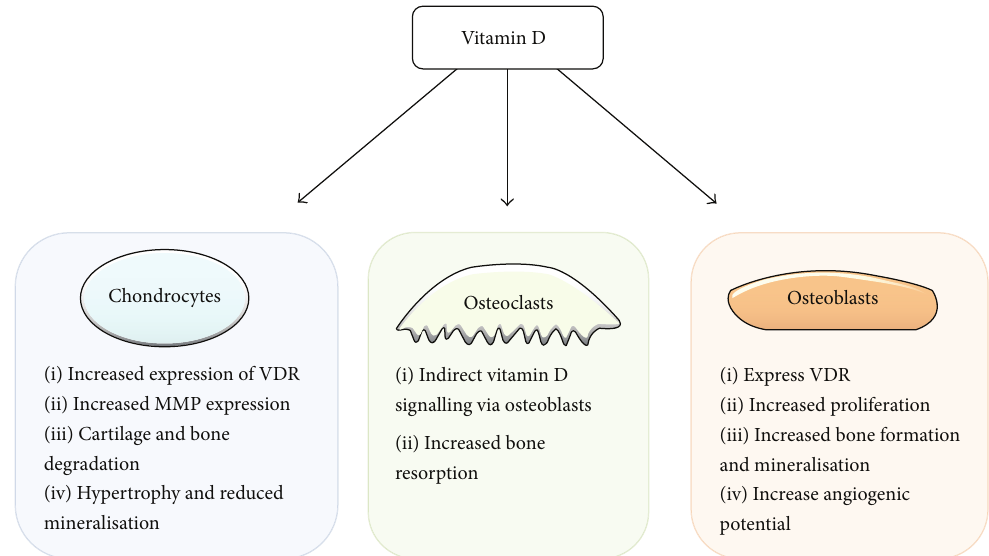
Figure 2: The effects of vitamin D on several different cell types in osteoarthritis including chondrocytes, osteoclasts, and osteoblasts. Vitamin D has a range of effects on cell types within osteoarthritis affected joints. Vitamin D acts through the vitamin D receptor and acts to alter gene expression which results in the phenotypic changes summarised here. Osteoclasts appear to respond indirectly to vitamin D signalling via osteoblasts and RANKL signalling. VDR: vitamin D receptor; MMP: matrix